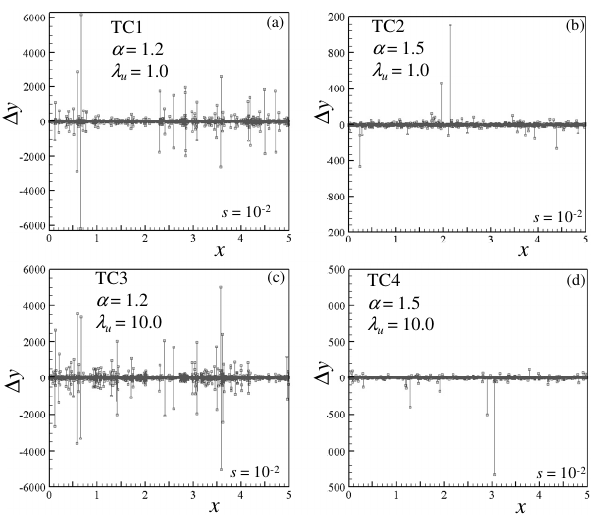
Fig. 1. Increments 1y (x,s ; λ l ,λ u ) evaluated at s = 10 − 2 for two values of α and λ u